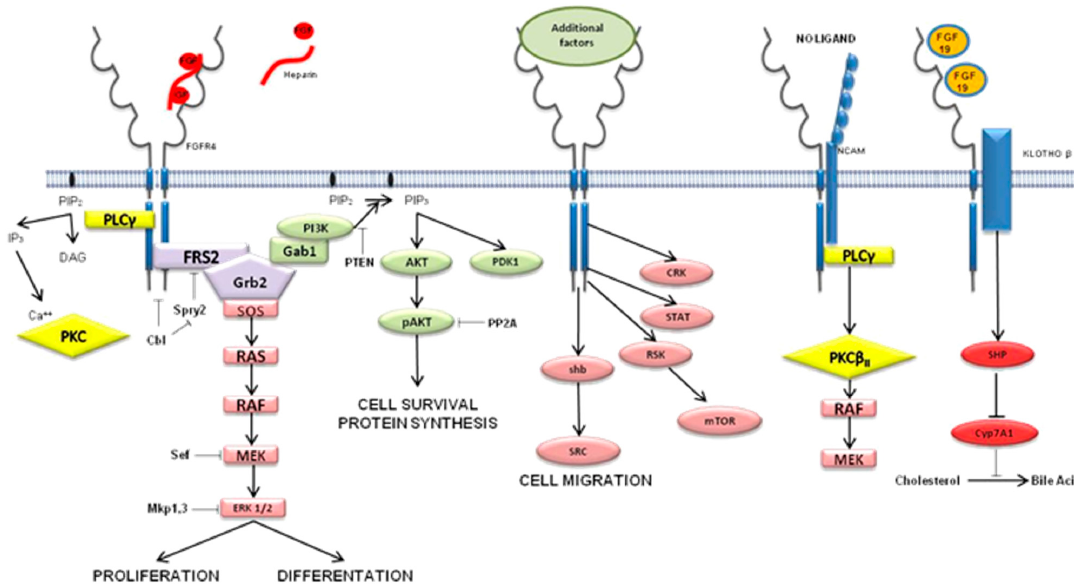
Figure 5. Involvement of FGFR4 -related signaling pathways. Involvement in cell proliferation is depicted on the far left; next to it the cell survival signaling pathway is shown, and on the right side the cell migration pathway is explained (adapted from Atlas of Genetics and Cytogenetics in Oncology and Haematology).